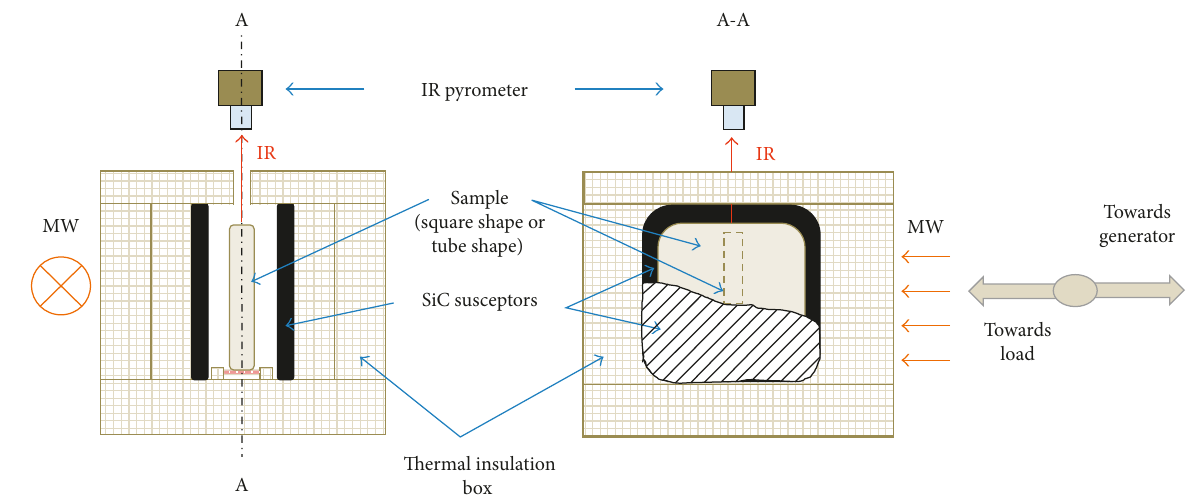
Figure 3: Scheme showing the assembly used to heat up the ceramic green sample into the 915MHz single-mode